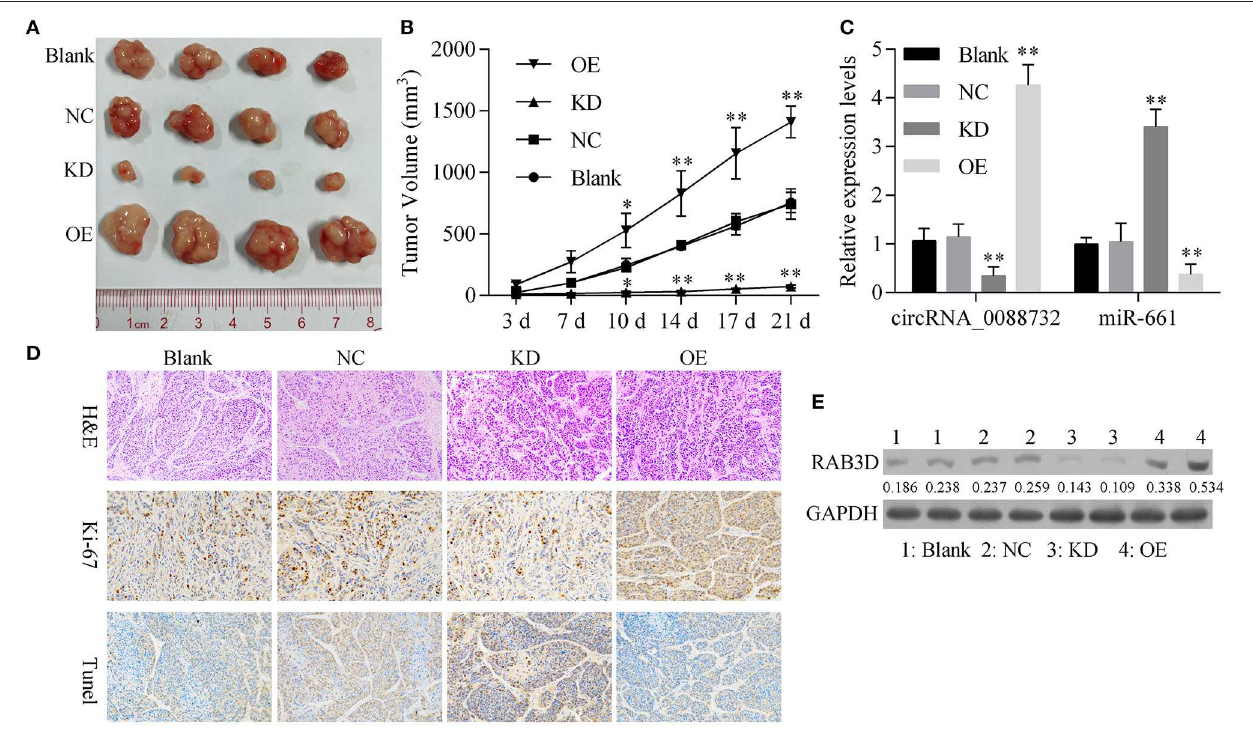
FIGURE 10 | Knockdown of hsa_circ_0088732 suppressed glioma growth in vivo . (A,B) Gross glioma tumor samples were taken from nude mice at 21 days after injection of LN229 cells (* P < 0.05, ** P < 0.01). (C) qRT-PCR was used to analyze hsa_circ_0088732 and miR-661 expression (** P < 0.01). (D) Representative images of H&E, Ki-67, and Tunel staining assays. (E) Western blot analysis of RAB3D expression. NC: negative control, KD: hsa_circ_0088732 siRNAs, OE: hsa_circ_0088732 overexpression plasmids.